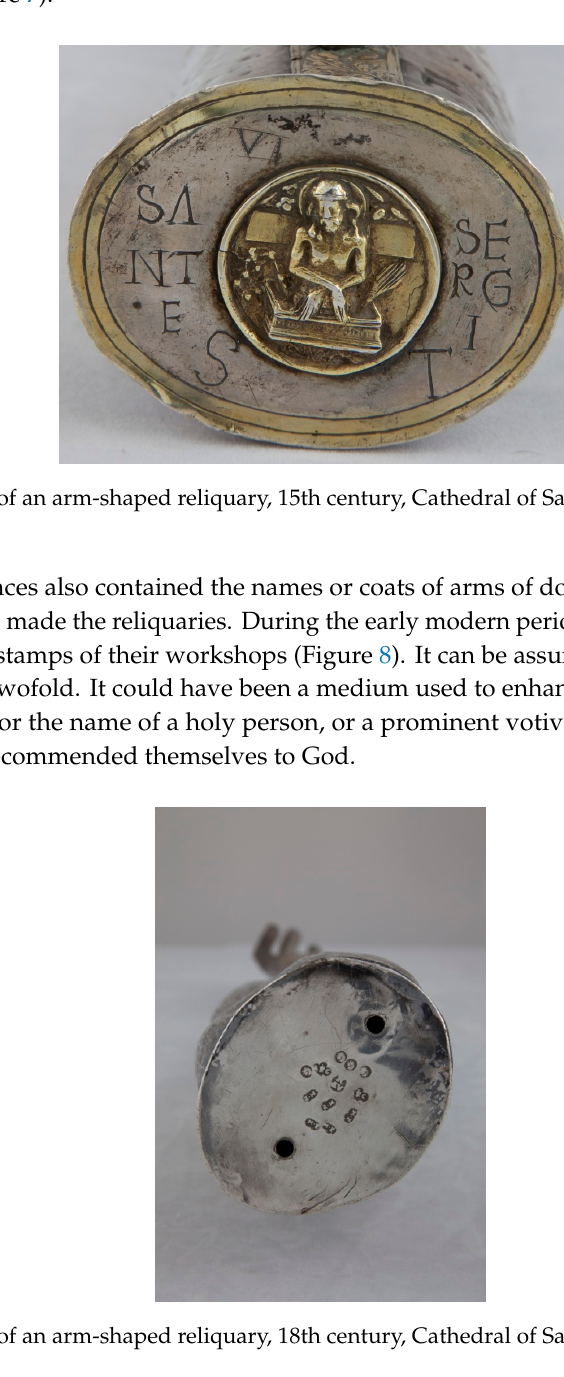
Figure 8. Bottom of an arm-shaped reliquary, 18th century, Cathedral of Saint Tryphon, Kotor, photo by Stevan Kordi ć .